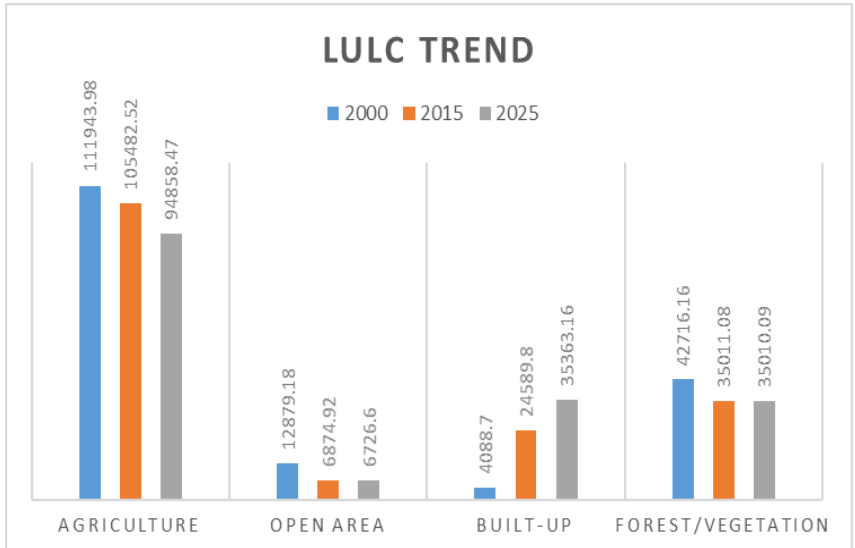
Figure 3. LULC trend from 2000 to 2025 (unit in ha)